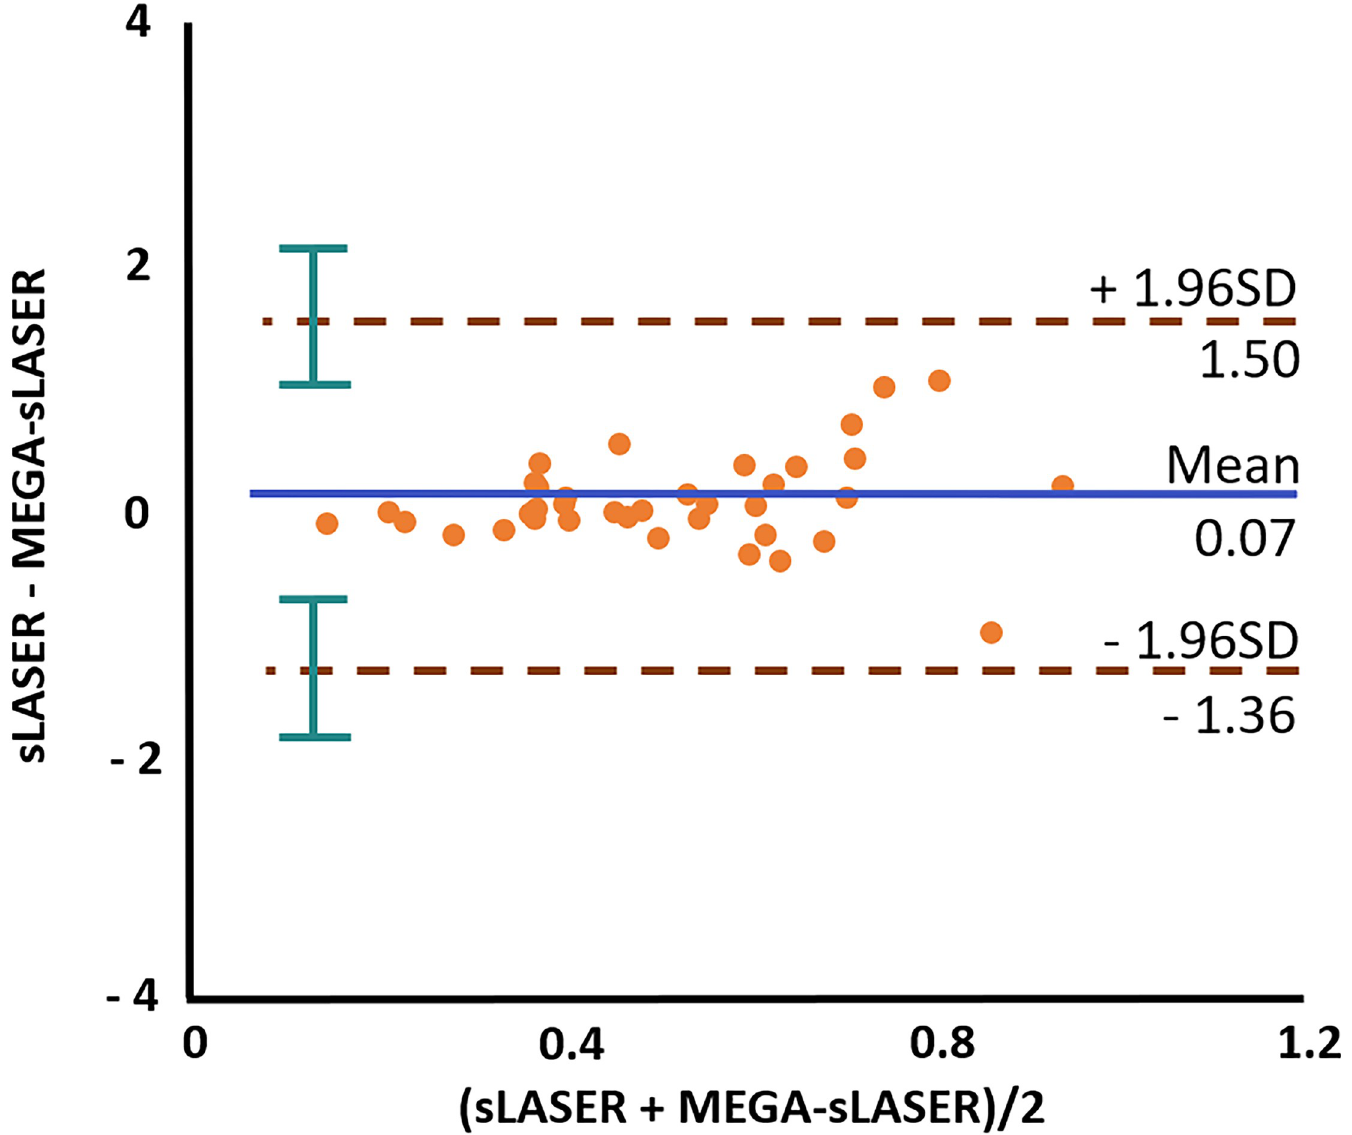
Fig 6. Bland-Altman plot for GABA. Bland-Altman plot of the GABA concentration from the interleaved measurements using the semi-LASER (sLASER) and MEGA-sLASER approaches afterthe LCModel analysis. The blue horizontal line shows a mean value and two brown lines show ± 1.96 � SD with 95% confidence intervals (green) across all